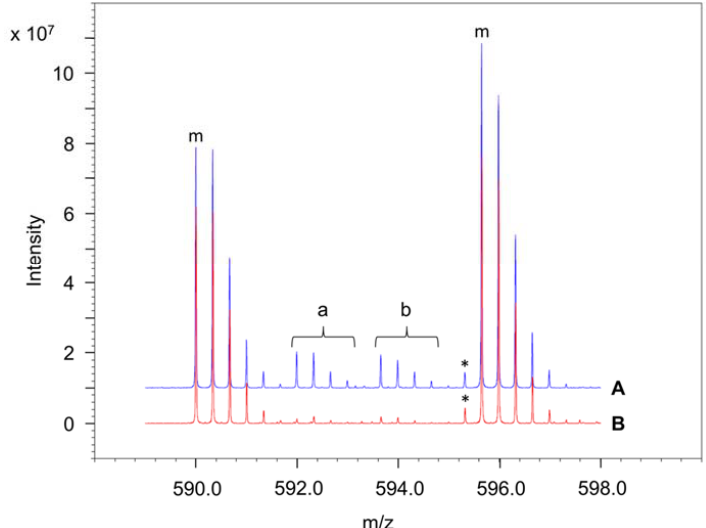
Figure 3. Fourier-transform ion cyclotron resonance (FTICR) mass spectra of the cross-link formed in FtsZ between K380 and K170. In the presence of ZapA, only intraprotein cross-links are formed (trace B). In the absence of ZapA and in the presence of Ca 2+ , a mixture of intraprotein and interprotein cross-links are formed (trace A). Cross-link experiments were carried out with 14 N- and 15 N-labelled FtsZ added to the reaction medium in a 1:1 ratio. The monoisotopic peaks in the 14 N- (left) and 15 N-(right) labelled peptides are marked m. Composing peptides of an intramolecular cross-link are either both 14 N-labelled (A, left spectrum) or 15 N-labelled (A, right spectrum). The peak marked with the asterisk indicates that the extent of 15 N labelling was about 95%. The presence of interprotein cross-links is revealed by the hybrid 14 N(LLKVGLR)– 15 N(KQAD) (a) and the hybrid 15 N(LLKVGLR)– 14